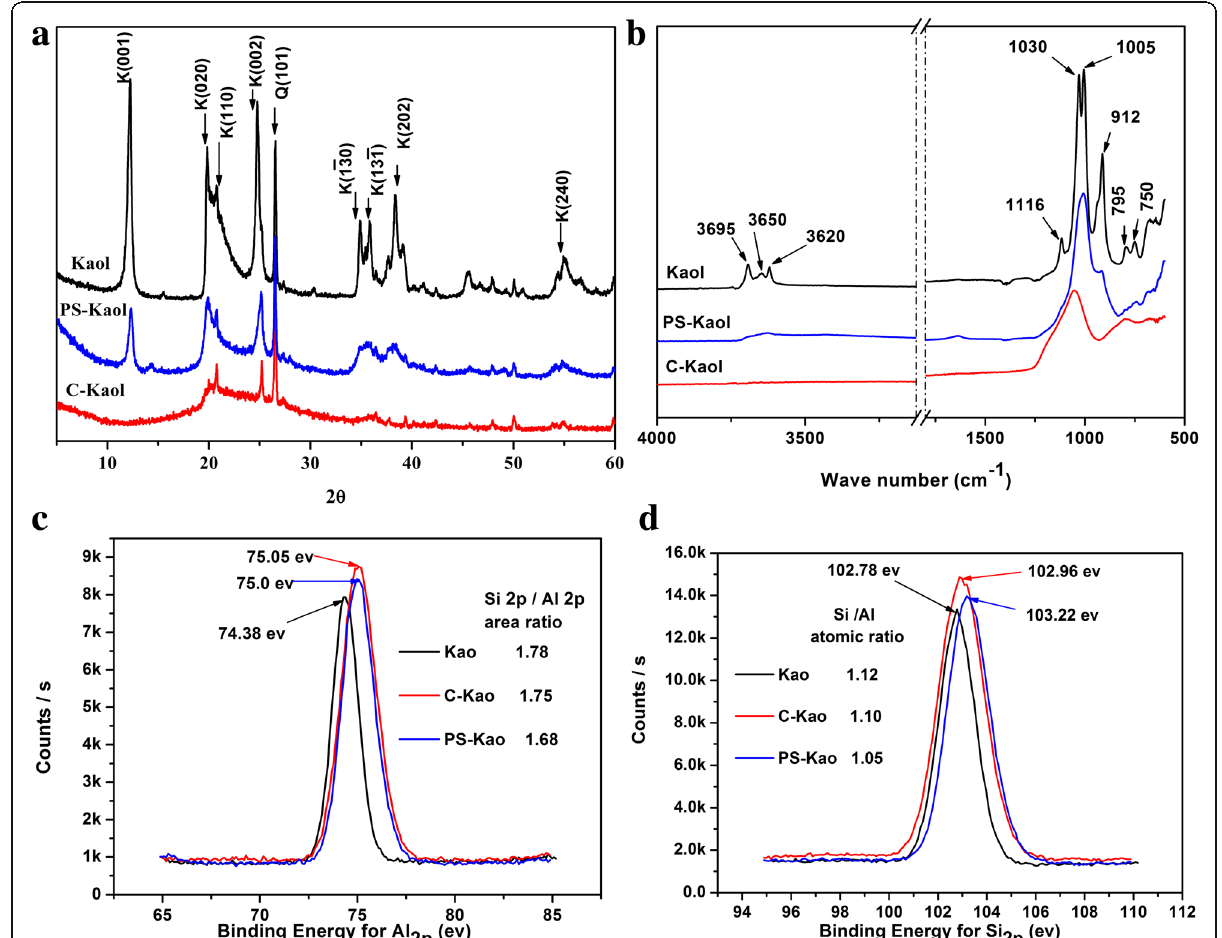
Fig. 1 a XRD patterns, b FTIR spectra, c Al 2p XPS spectra, and d Si 2p XPS spectra of the samples Kaol, calcined Kaolinite (C-Kaol), and the hydrothermal treatment calcined Kaolinite